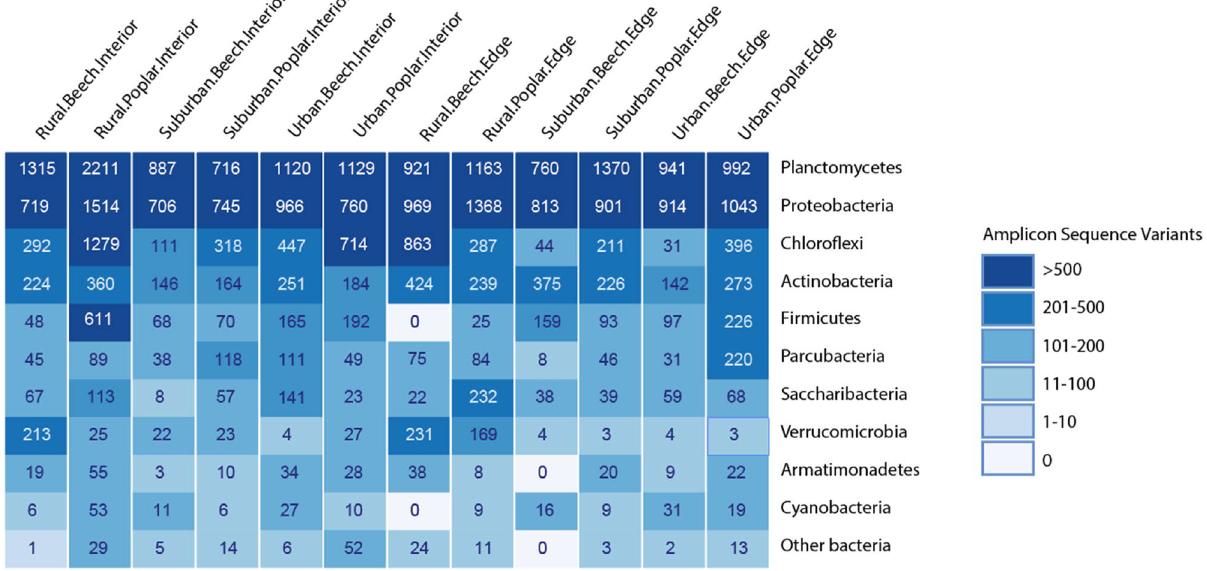
Figure 2. Heatmap depicting average relative abundance of the soil microbial community at the phyla level. Numbers within boxes indicate ASVs identified for each tree, forest, and